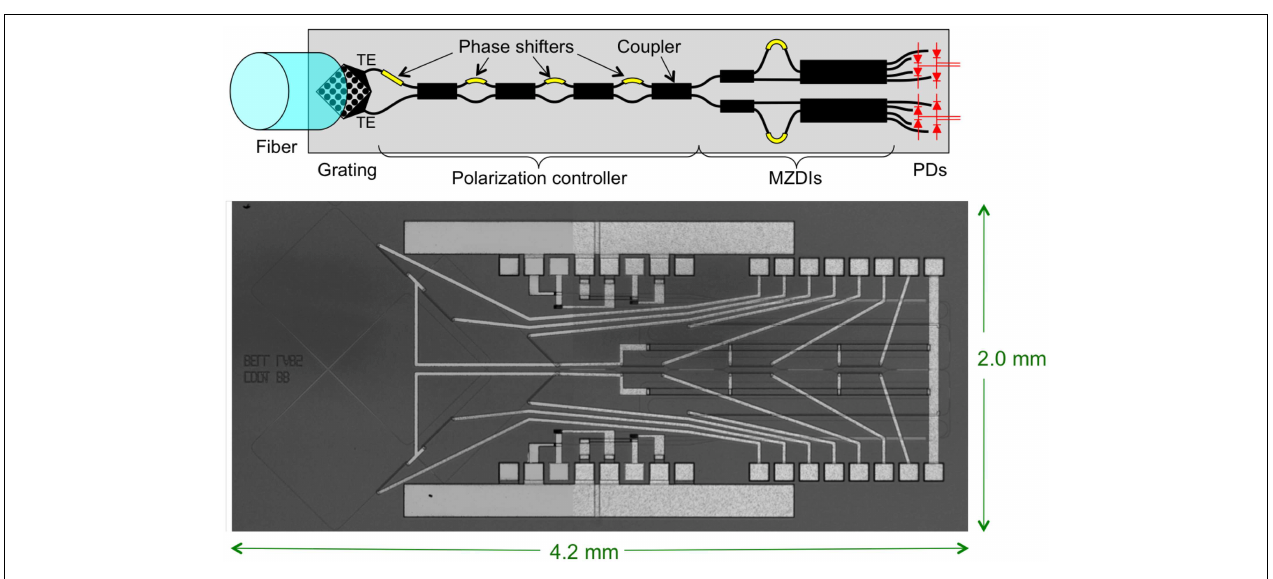
polarizations by a 2D grating coupler, a series of couplers and phase shifters demultiplex the two signals, which had been mixed during fiber transmission, and two Mach-Zehnder delay interferometers demodulate the signals.